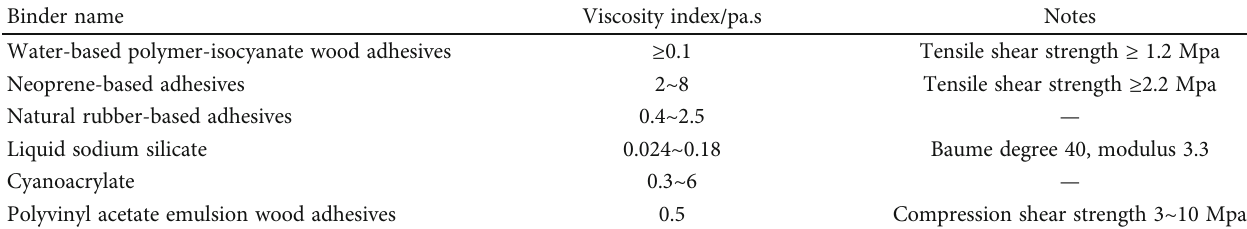
Table 2: Statistics of common binder materials.